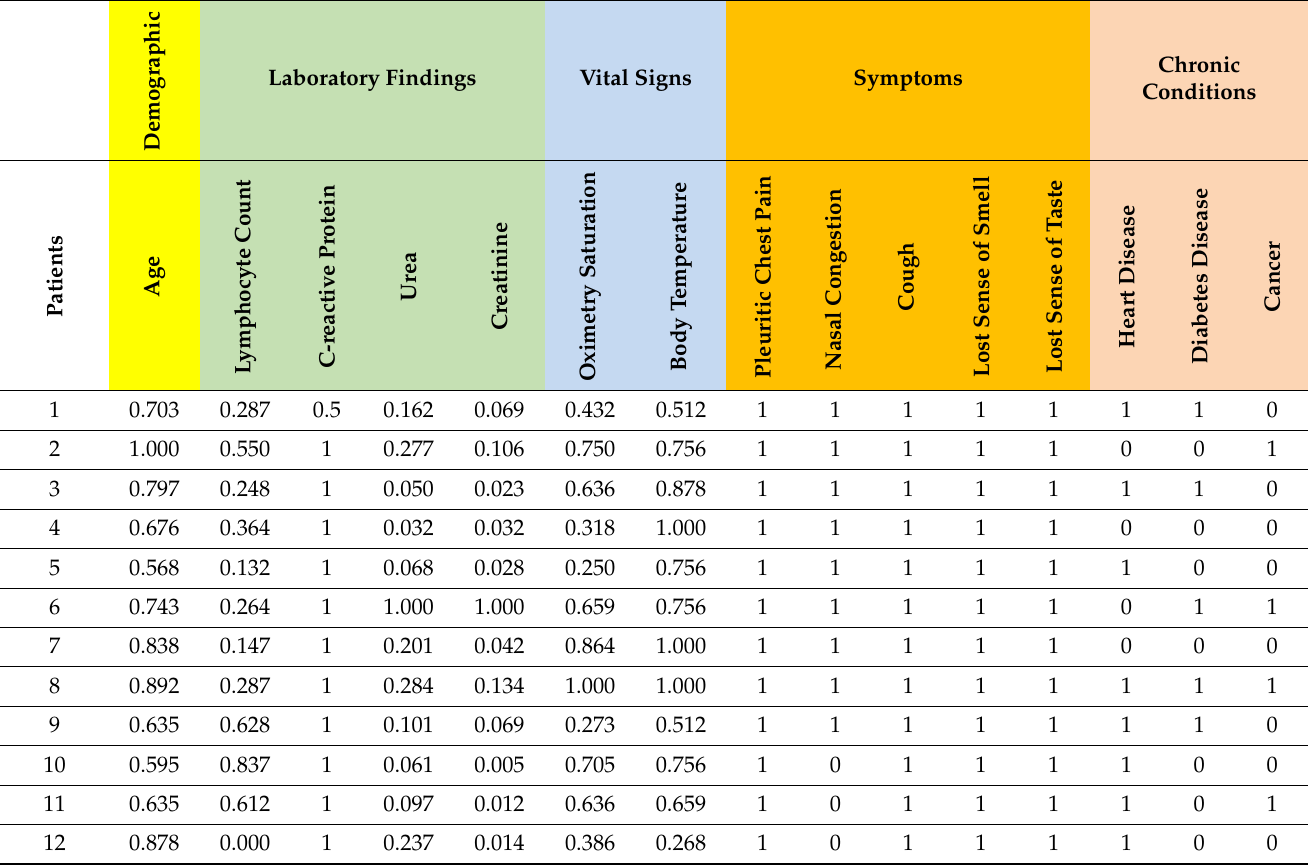
Table A1. The normalized MEM based on the CRITIC